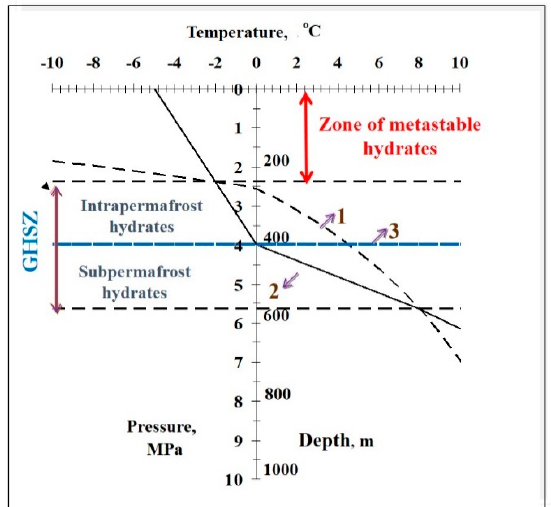
Figure 2. Conditions for gas hydrate existence in permafrost. 1 = equilibrium curve of gas hydrate stability; 2 = temperature distribution along the cross section; 3 = permafrost base. GHSZ: gas hydrate stability zone.